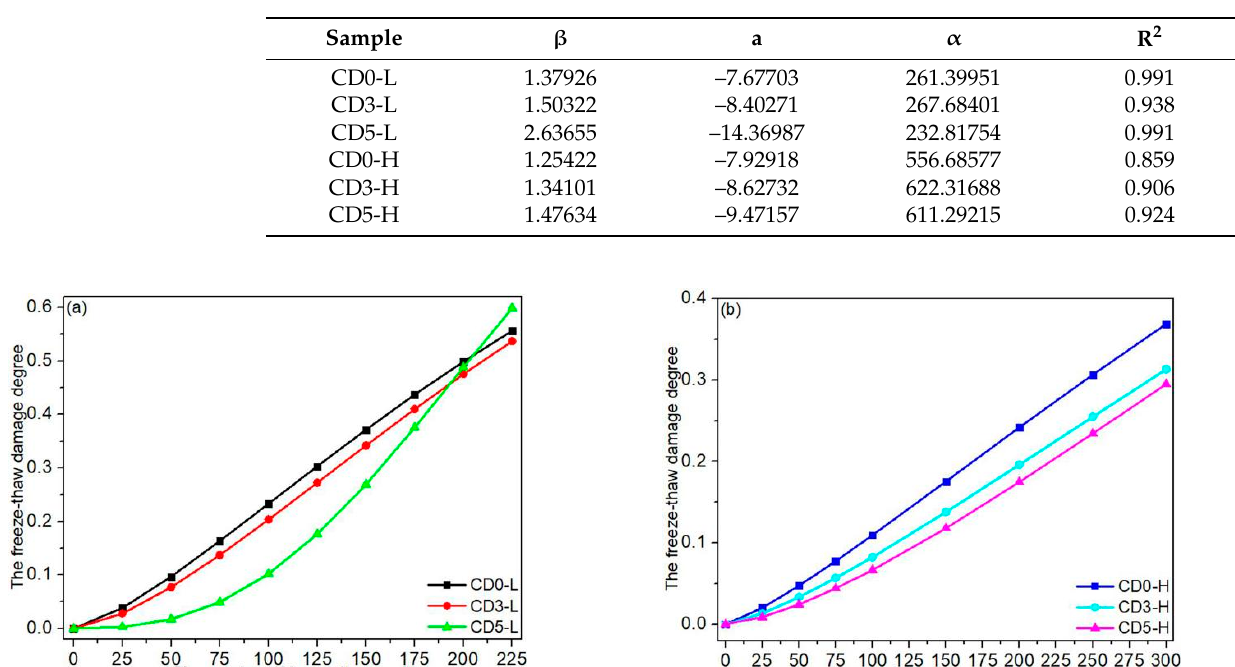
Figure 8. Graphical analysis of the freeze–thaw damage for: ( a ) CD0-L; ( b ) CD3-L; ( c ) CD5-L; ( d ) CD0-H; ( e ) CD3-H; ( f ) CD5-H. Table 6. Weibull distribution characteristic parameters. Table 6. Weibull distribution characteristic parameters.